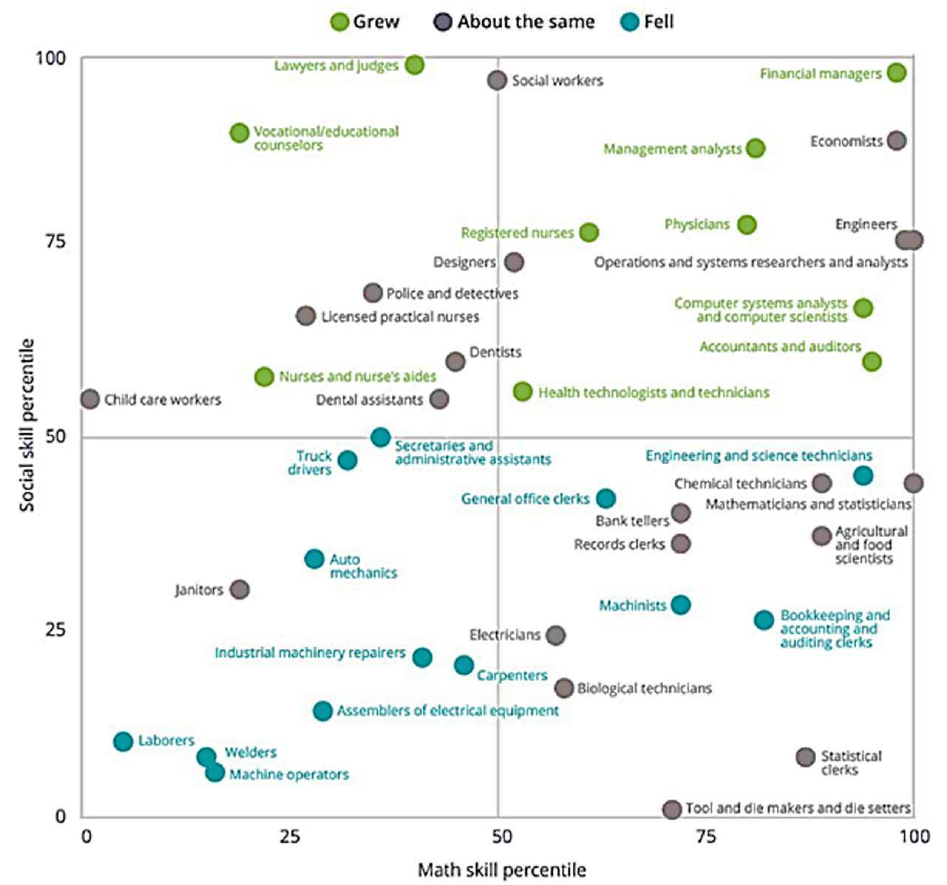
Figure 13. Which jobs require social skills? Change in share of jobs, 1980–2012